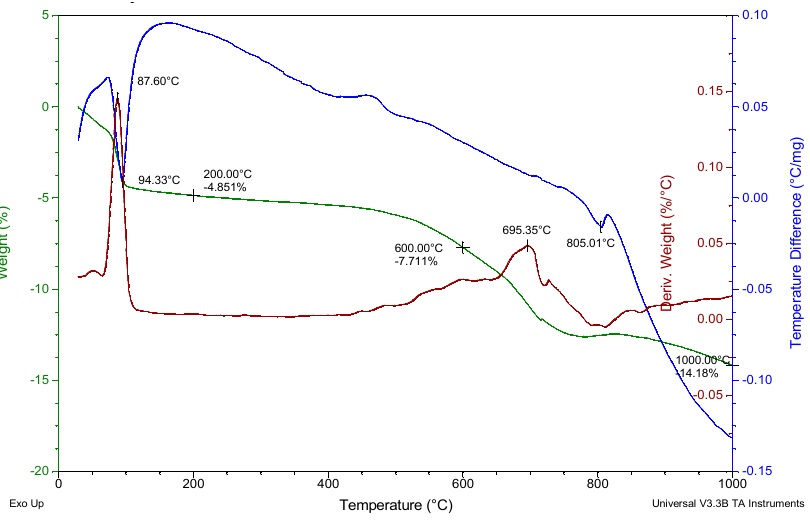
Figure 5. TG ‐ DTA curve of sample mixed Cr 2 O 3 and Na 2 CO 3 in a 1:1 ratio. Figure 5. TG-DTA curve of sample mixed Cr 2 O 3 and Na 2 CO 3 in a 1:1